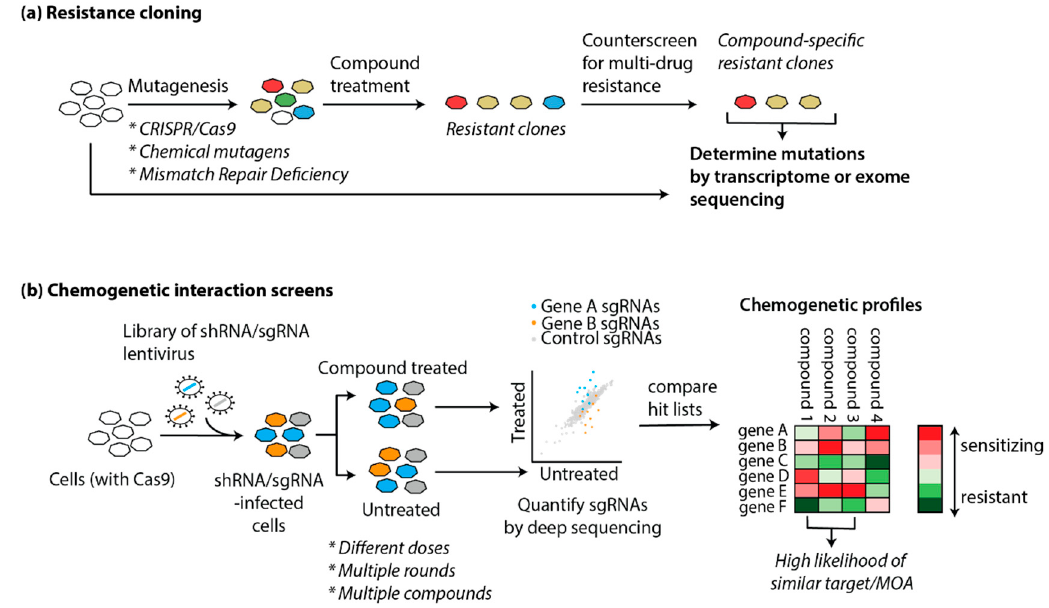
Figure3. Geneticmethodsfortargetidentificationandmodeofactionstudies. Schematicrepresentations Figure 3. Genetic methods for target identification and mode of action studies. Schematic of ( a ) resistance cloning, and ( b ) chemogenetic interaction representations of ( a ) resistance cloning, and ( b ) chemogenetic interaction screens.